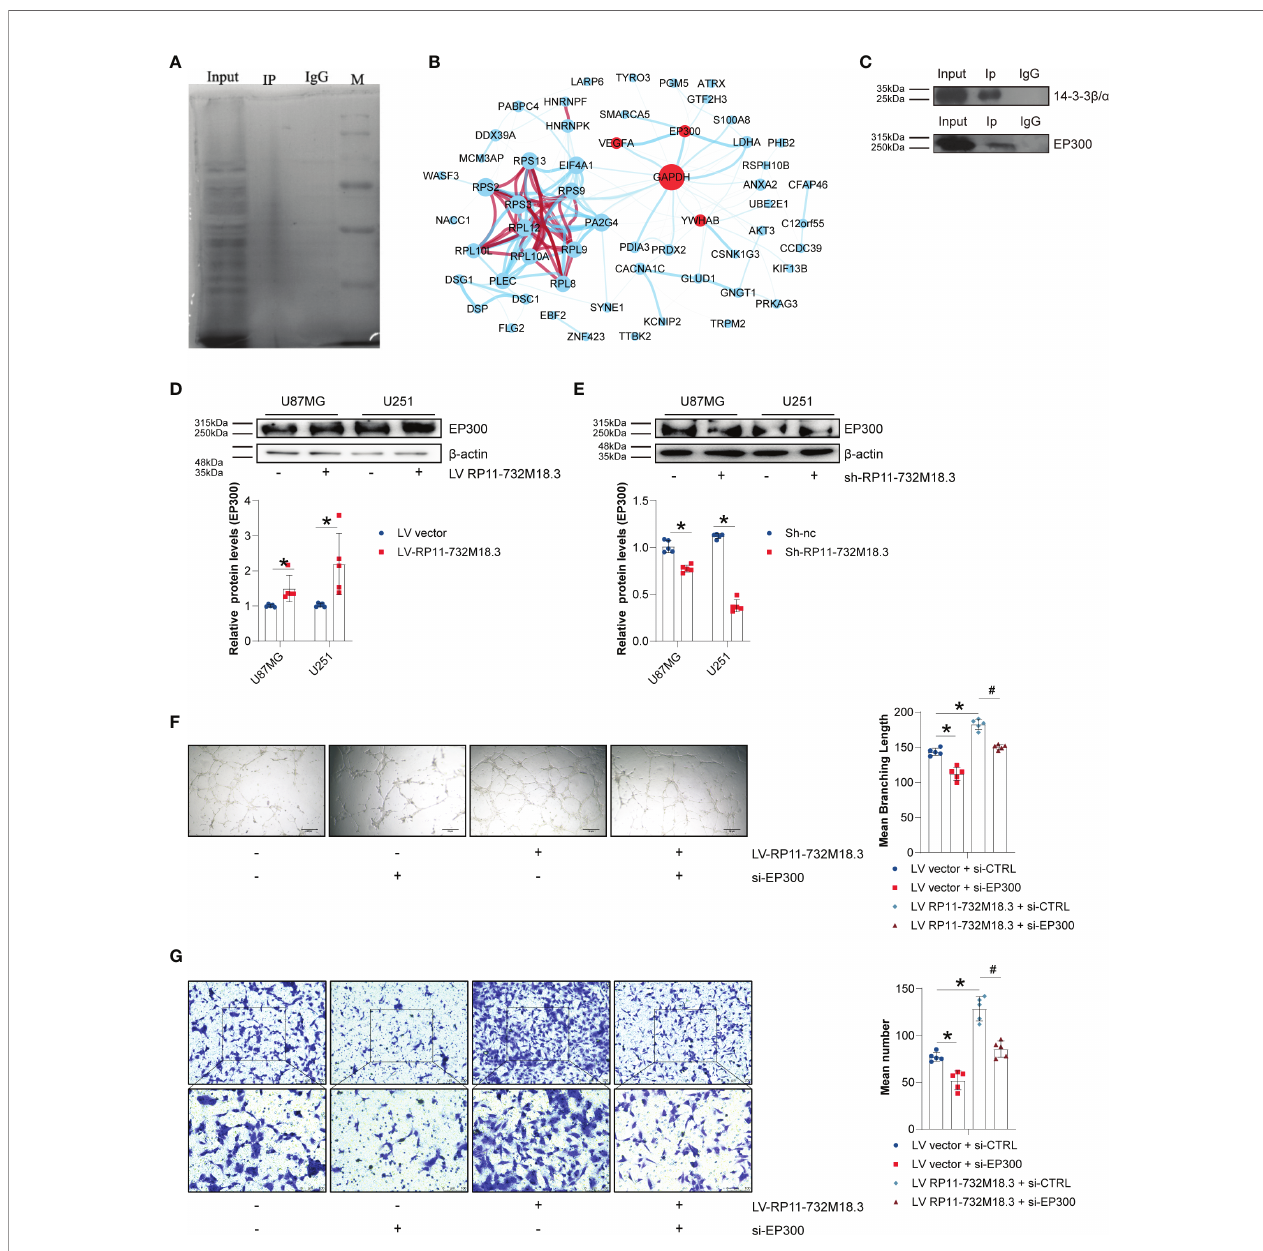
FIGURE 5 | lncRNA RP11-732M18.3 promotes angiogenesis through EP300. (A) The target protein 14-3-3 b / a was speci fi cally co-immunoprecipitated (Co-IP) from U87MG cell extracts and the immunoprecipitates were validated using tandem mass spectrometry. Total protein was detected using silver stain. (B) Cytoscape networks of VEGFA with speci fi c protein band analysis with Co-IP performed with an anti-4-3-3 b / a antibody. There are approximately 201 more proteins that interact with 14-3-3 b / a . The circle size represents protein content, line represent the evidence for the association, and the thickness of the lines indicates the strength of association; Red circle represents core genes interested; blue lines represents interactions and red line represents protein homology;. (C) Co-IP of 14-3-3 b / a was followed by WB. The interaction between 14-3-3 b / a and EP300 was validated. (D, E) The expression of EP300 was detected using WB in indicated cells. lncRNA-RP11-732M18.3 increased the expression of EP300. All experiments were performed in triplicate (n = 5, * p < 0.05). (F) EP300 mediates lncRNA-RP11-732M18.3 regulation offormation of tumor vessels. All experiments were performed in triplicate (n = 5, * p < 0.05). (G) EP300 mediates lncRNA-RP11-732M18.3 regulation of EC migration. All experiments were performed in triplicate (n = 5, * p < 0.05). # p <